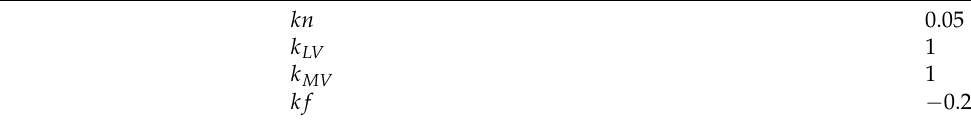
Table 6. FRT control